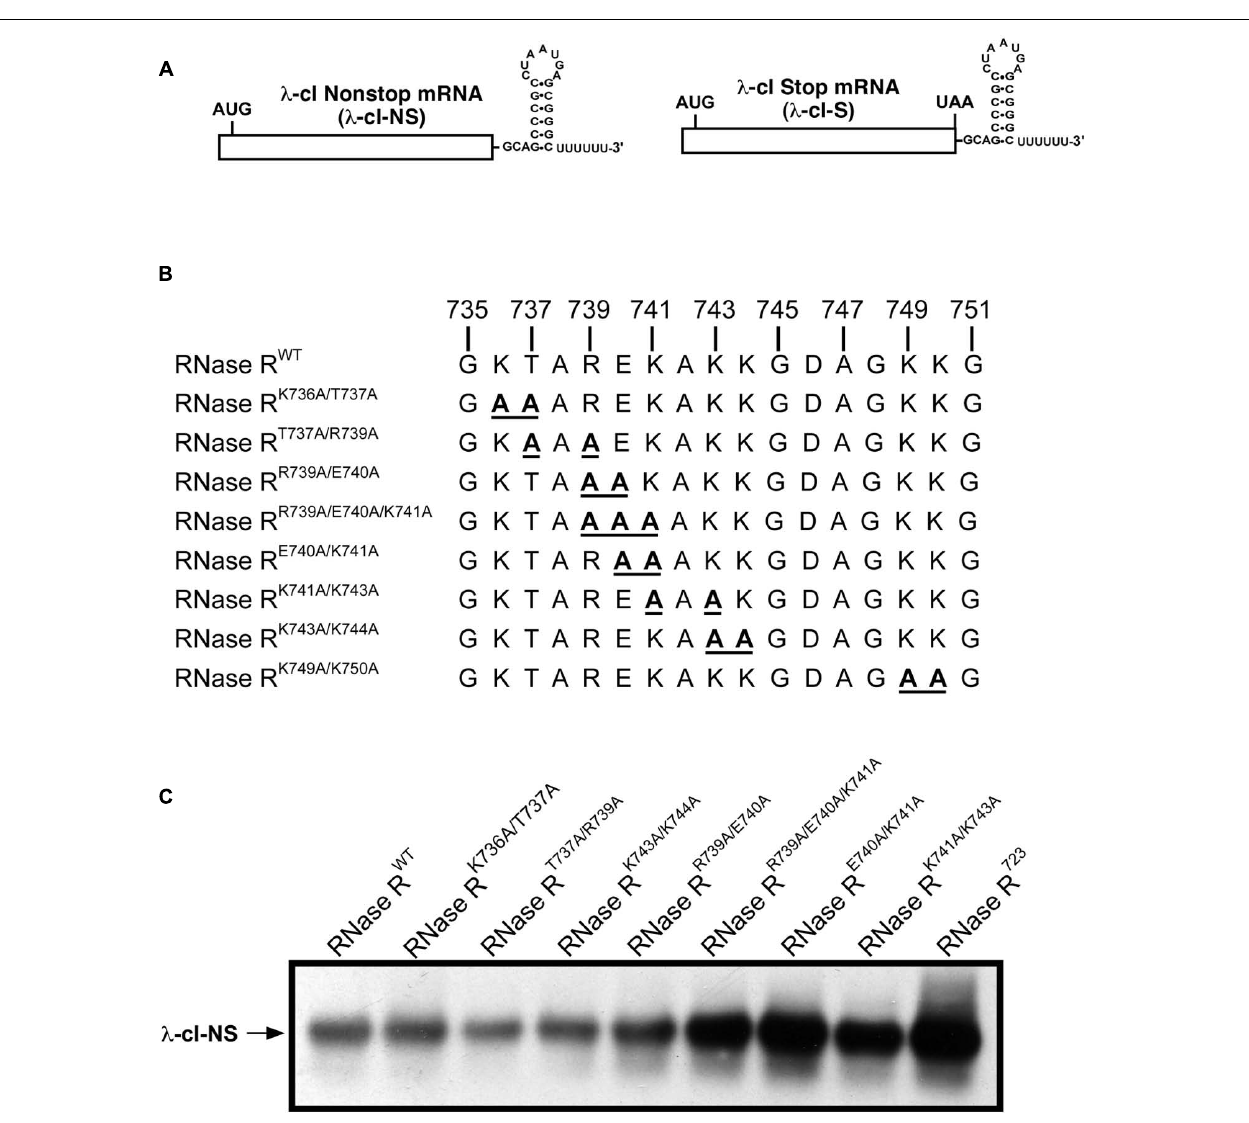
representative Northern blot showing the effect of alanine substitutions in the region between residues 735 and 750 on non-stop mRNA accumulation. Cells co-expressing the λ -cI-NS reporter with indicated plasmid-borne RNase R variants were harvested.Total RNA samples isolated from equal number of cells were resolved by electrophoresis on denaturing formaldehyde agarose gels followed by Northern blot analysis with a probe specific for the reporter RNA. Alanine substitutions at residues E740 and K741 exhibit significant defect in non-stop mRNA